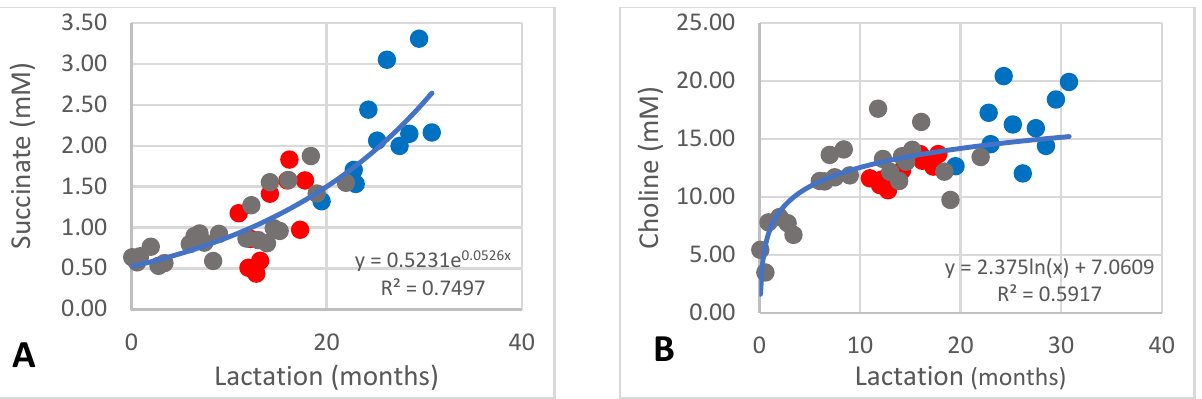
Figure 4. Changes of succinate ( A ) and choline ( B ) in milk of African elephants (Shorty ● , Mussina ● , Shan ● ). Trend lines, formulas, and R 2 values were calculated from the combined data of the three elephants.